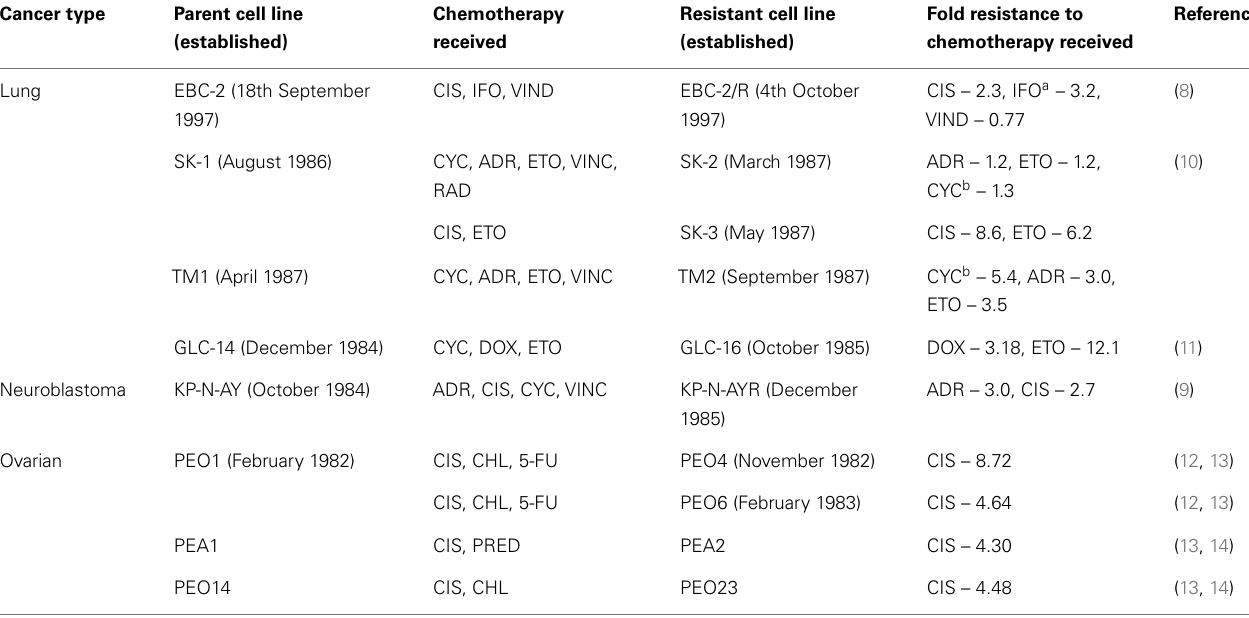
Table 1 | Cell lines established from cancer patients before and after chemotherapy